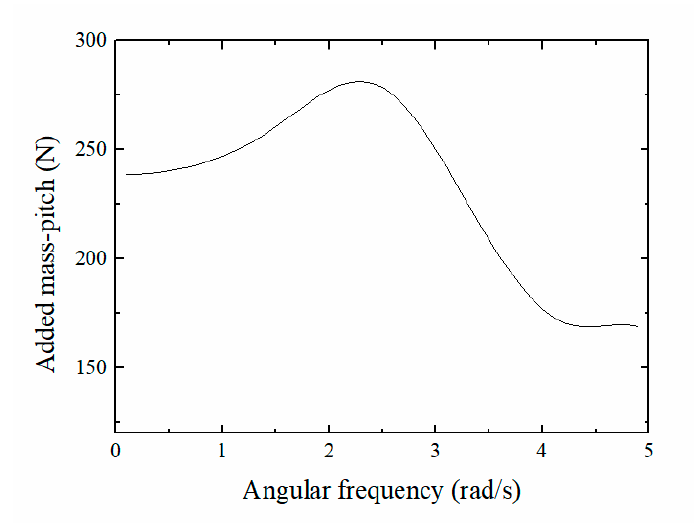
Figure 10. Additional mass force in the pitching direction.